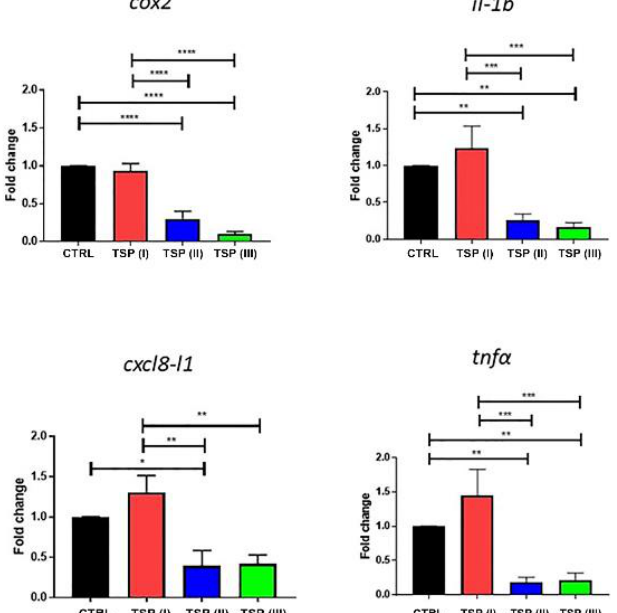
Figure 4. Relative mRNA expression of inflammatory factors in the intestines of zebrafish fed a plant-based diet (control — CTRL) (black column) or a plant-based diet supplemented with TSP at 0.9 g/kg of feed (TSP I), 1.7 g/kg of feed (TSP II), or 3.4 g/kg of feed (TSP III). Only the significant differences are reported. Error bars represent the standard errors of the means (SEMs). **** p < 0.00001, *** p < 0.0001, ** p < 0.001, * p < 0.05.